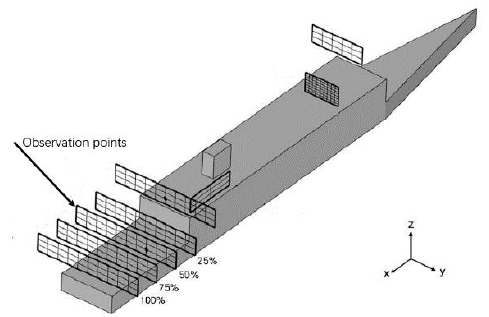
Figure 7. Location of observation points.